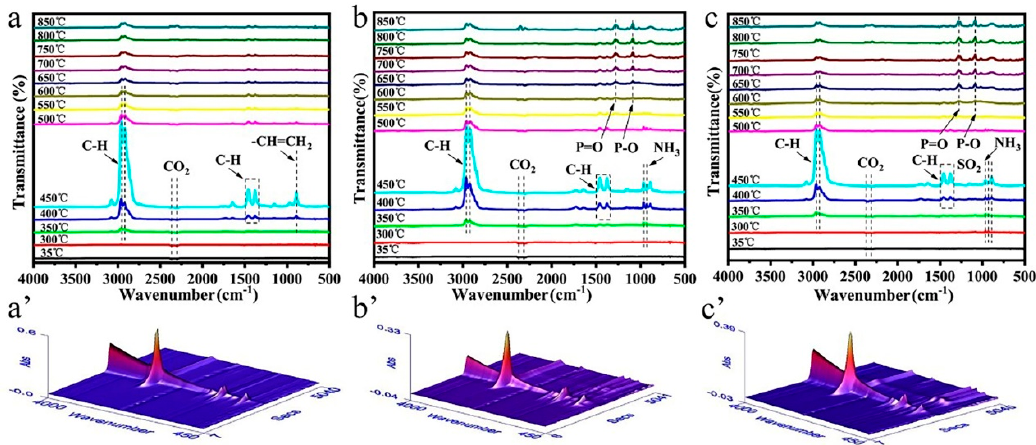
Figure 7. FTIR spectra and 3D images of the pyrolysis products of pure PP ( a , a’ ), PP/25%APP ( b , b’ ), and PP/25%MAPP ( c , c’ ) at different temperatures.